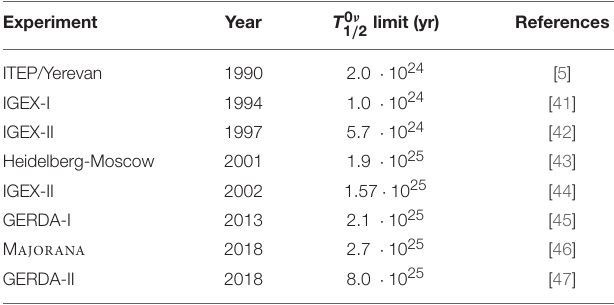
TABLE 2 | Results of 76 Ge 0 νββ experiments using Ge enriched in 76 Ge